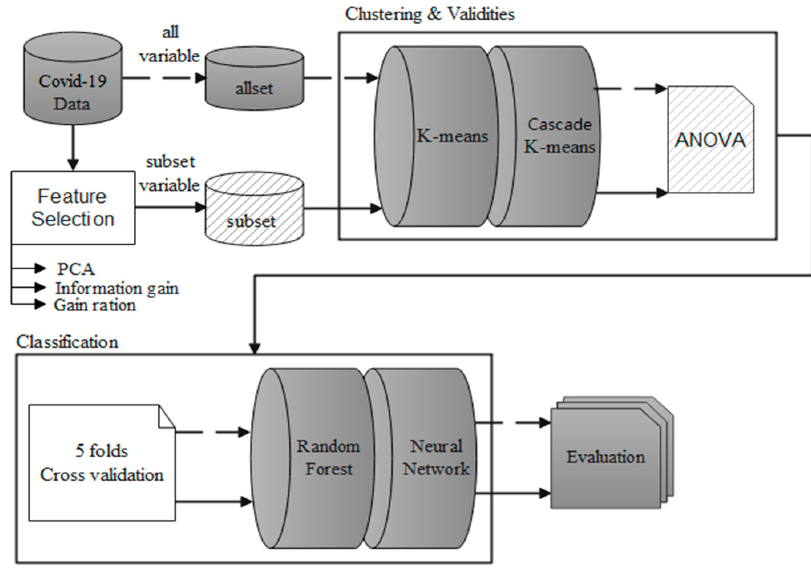
Figure 1. Clustering analysis and classifications scenario.